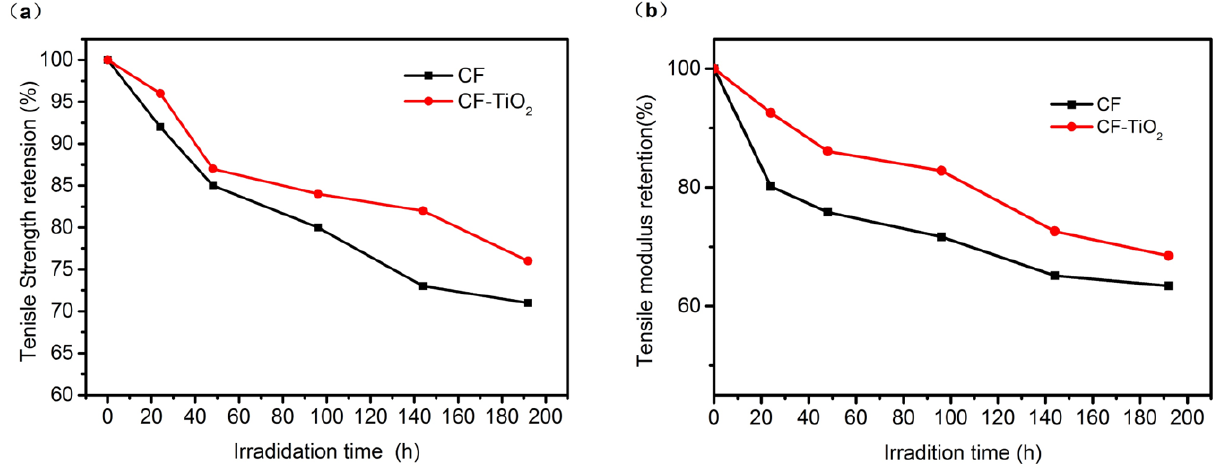
Figure 11. Mechanical properties of CF and CF-TiO 2 after UV irradiation: ( a ) Tensile Strength retention (%); ( b ) Tensile modulus retention (%).